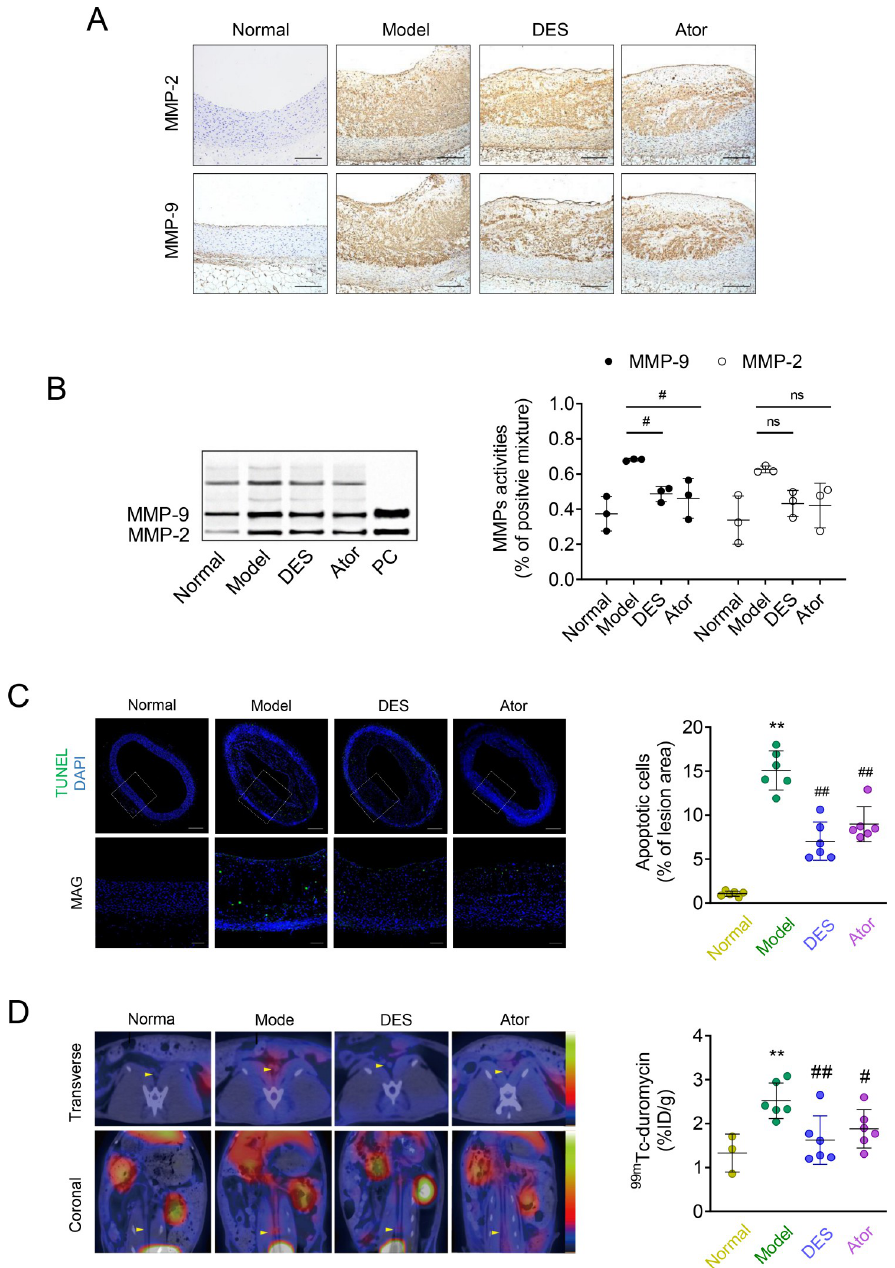
Fig 3. Desipramine and atorvastatin inhibit MMPs and apoptosis in atherosclerotic plaques. (A) Immunohistological staining and positive area analysis of MMP-2 and MMP-9 in abdominal aortas in 4 groups. Scale bar = 250 μ m; (B) Zymographic analysis of MMP-2 and MMP-9 activities, the densitometry of each band was determined by ImageJ software and calculated as the percentage of the positive control (PC) on each gel. (C) Representative micrographs and quantification of TUNEL-positive (green) cells in aortic atherosclerotic plaques. Scale bar = 50 mm; (D) In vivo imaging of abdominal aorta (arrowheads) with 99m Tc-duramycin SPECT/CT and measurement of radioactive 99m Tc-duramycin uptake in aortic; n = 3 and 6. � , �� represent P < 0.05, P < 0.01 in comparison with Normal; #, ## represent P < 0.05, P < 0.01 in comparison with Model, ns represents no-significance in comparison with